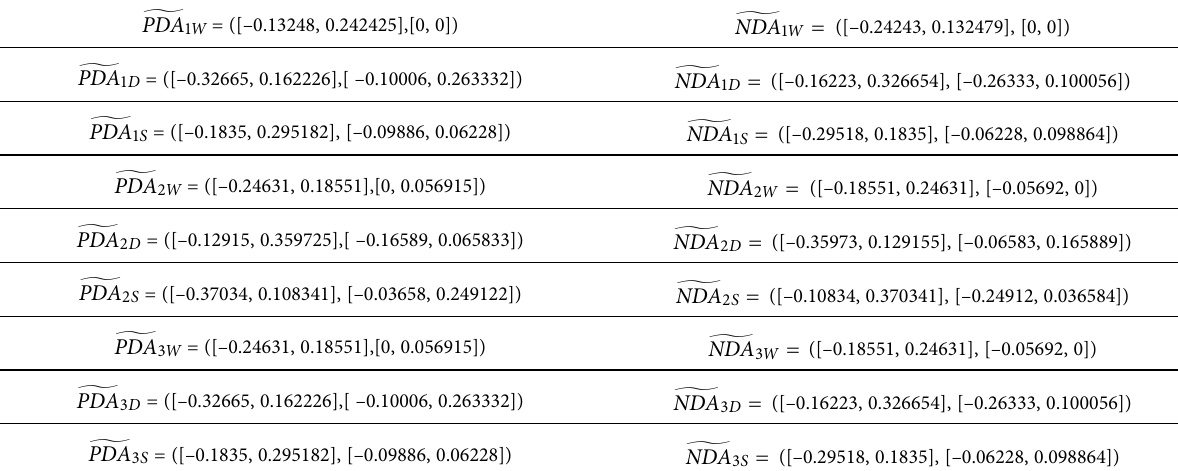
Table 9. PDA and NDA values of